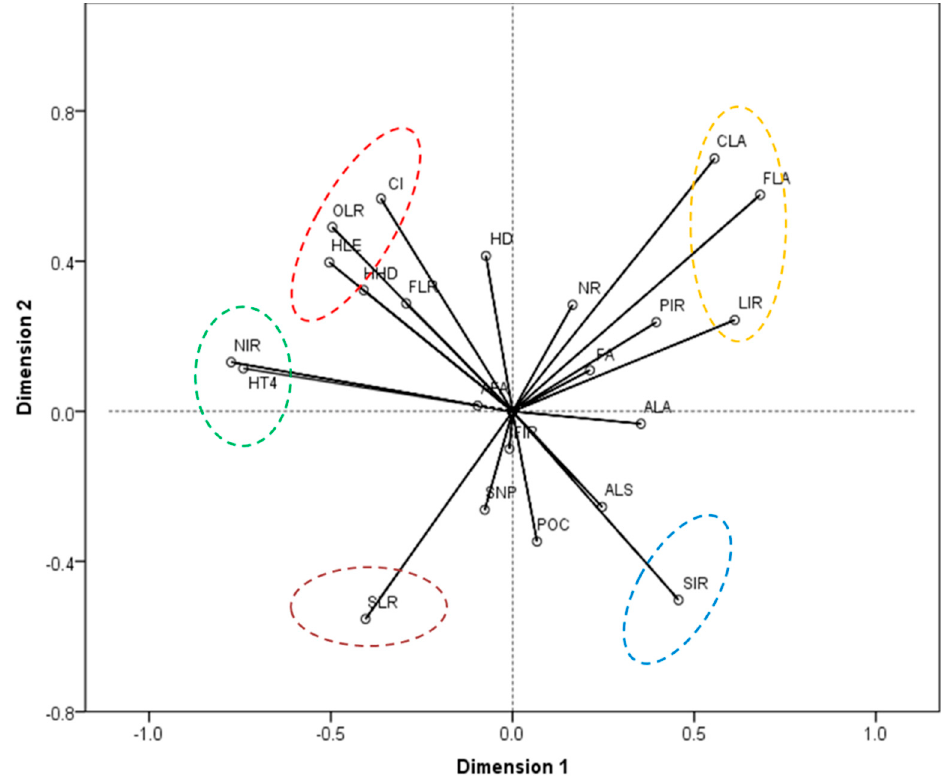
Figure 2. Component loading plot obtained from CATPCA describing the relationships between household characteristics. Table 3. CATPCA component loading results for the study area.